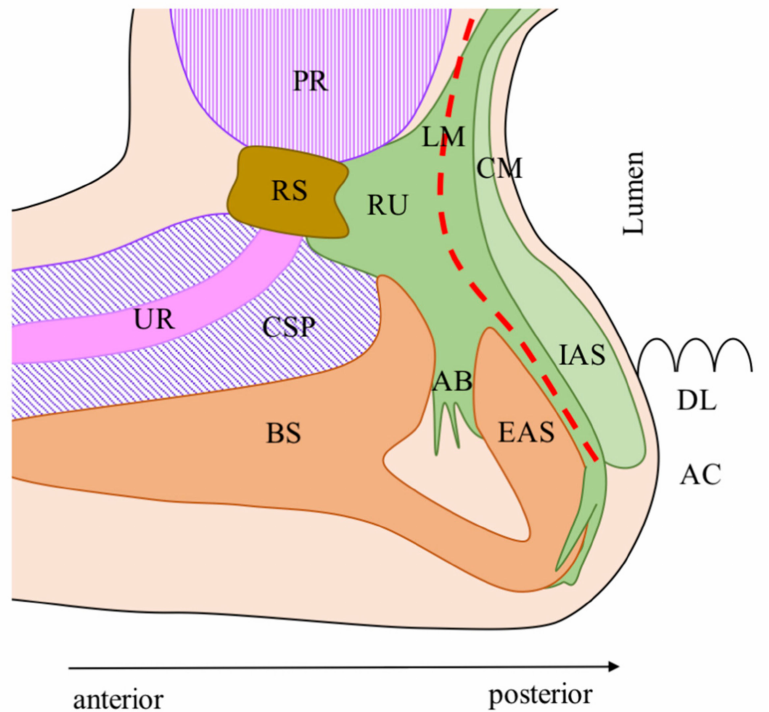
Figure 2. Male’s anterior anatomy. AB: Anterior bundle of the LM; AC: Anal canal; BS: Bulbospon- giosus muscle; CM: Circular muscle of the anal canal; CSP: Corpus spongiosum of the penis; DL: Dentate line; EAS: External anal sphincter; IAS: Internal anal sphincter; LM: Longitudinal muscle of the anal canal; PR: Prostate; RS: Urethral rhabdosphincter; RU: Rectourethralis muscle; UR: Urethra; Red line: Dissection plane during intersphincteric resection. The anatomic model was designed according to the descriptions of Nakajima et al. [32]. Modified and reprinted with permission from ref. [20]. Copyright 2020 Turkish Journal of Colorectal